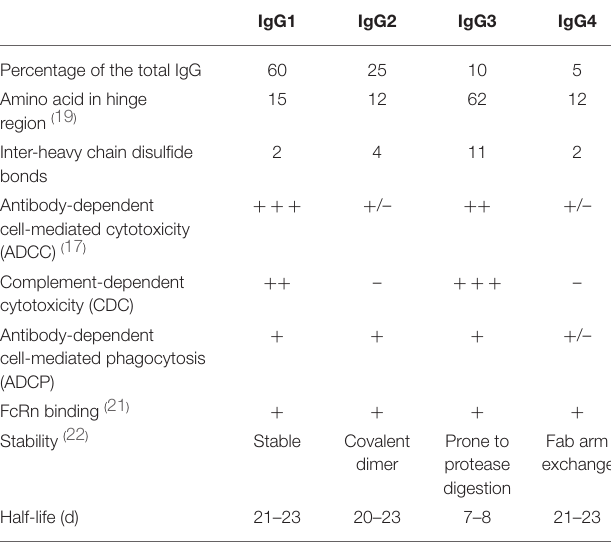
TABLE 1 | Comparison of the four human IgG